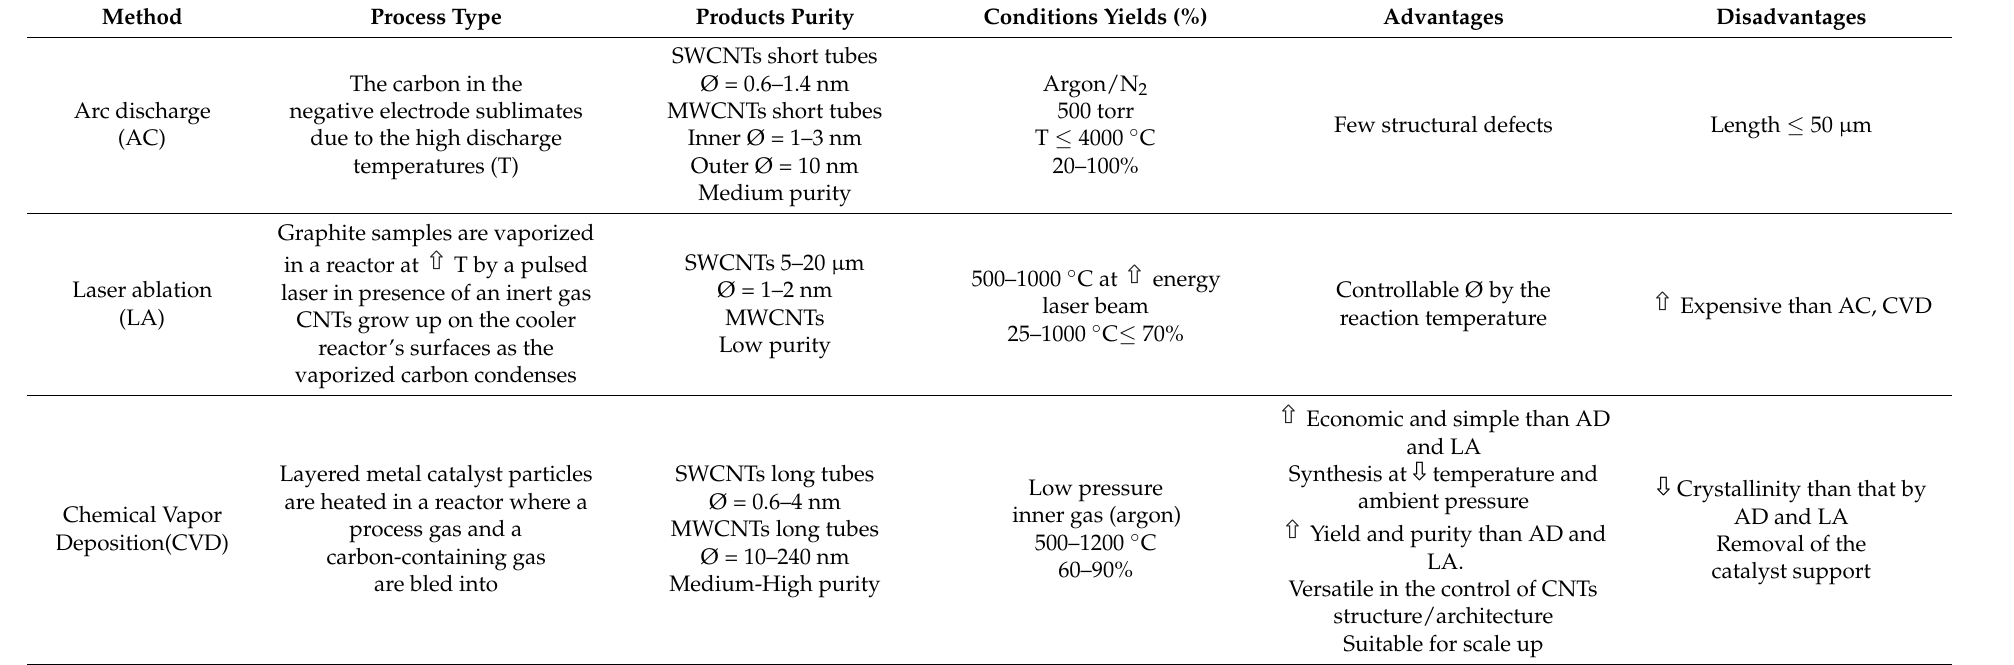
Table 5. The three most applied methods to synthetize CNTs.